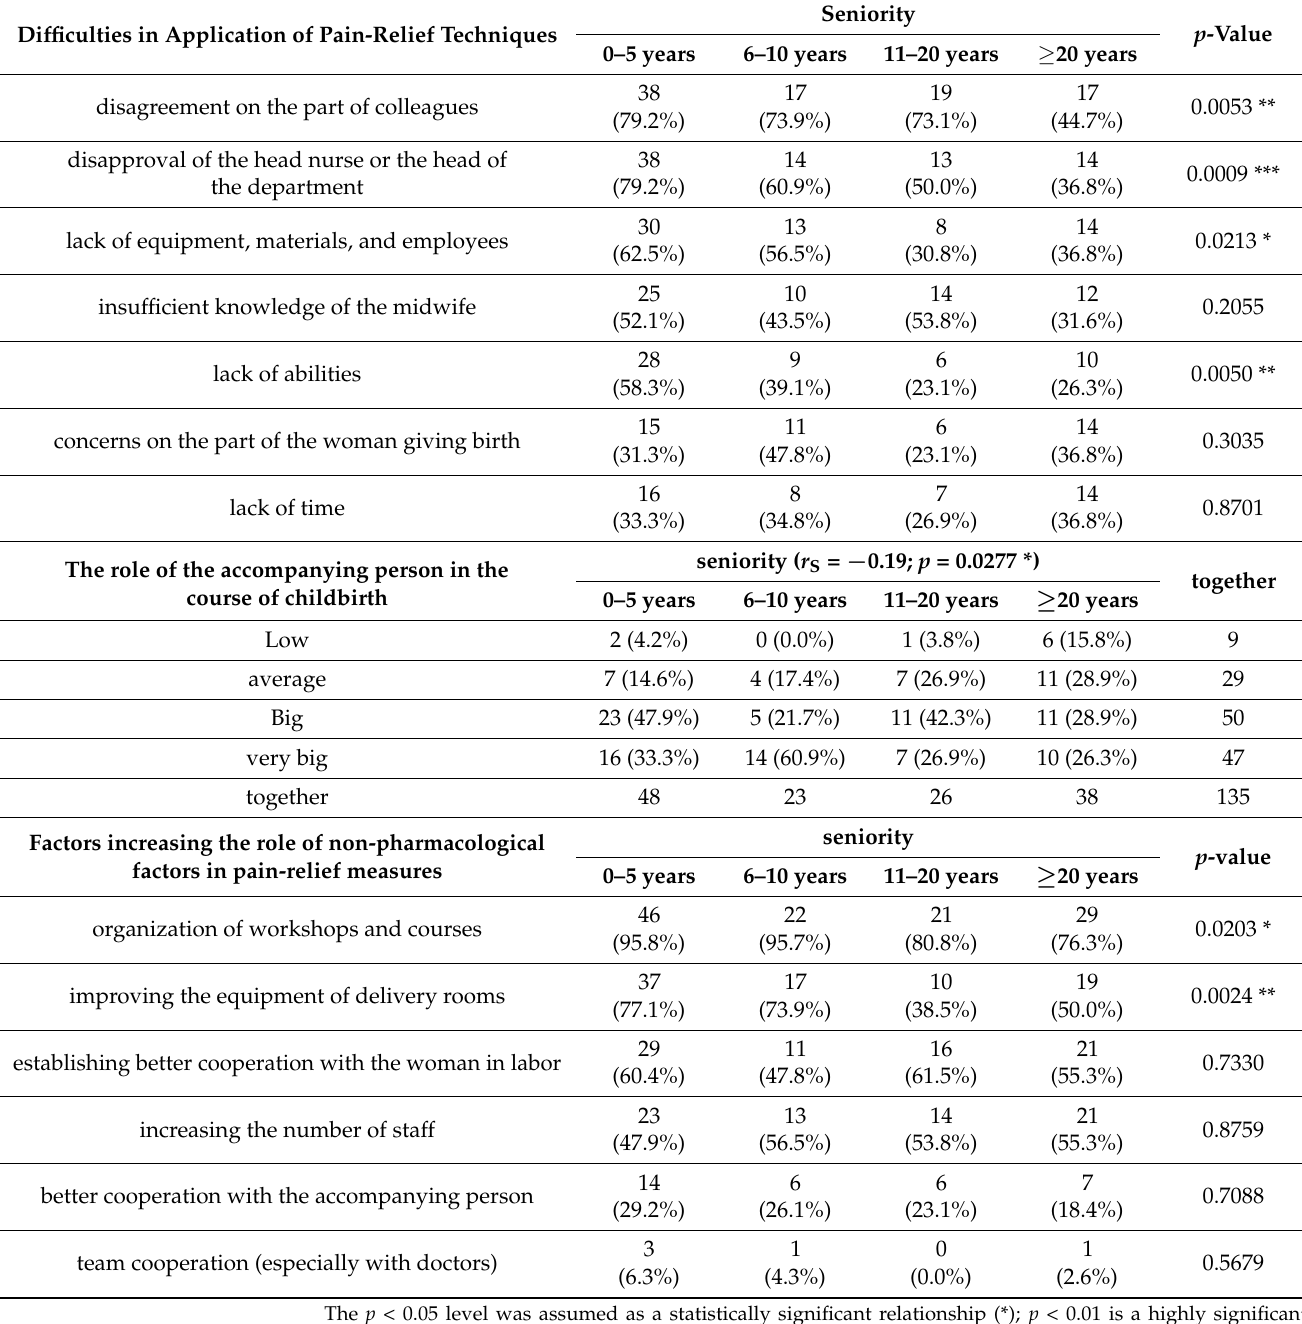
Table 4. Difficulties in the use of pain-relief techniques according to the interviewed midwives in relation to their